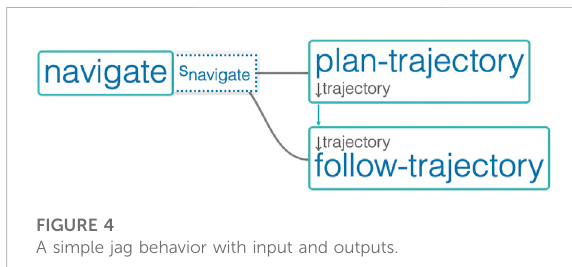
FIGURE 4 A simple jag behavior with input and